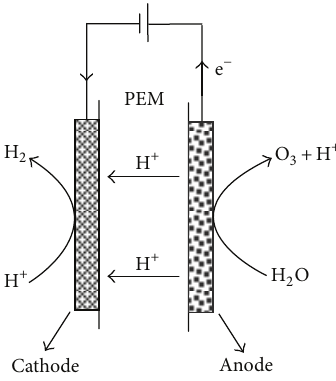
Figure 1: Schematic drawing of the new cell configuration without acid